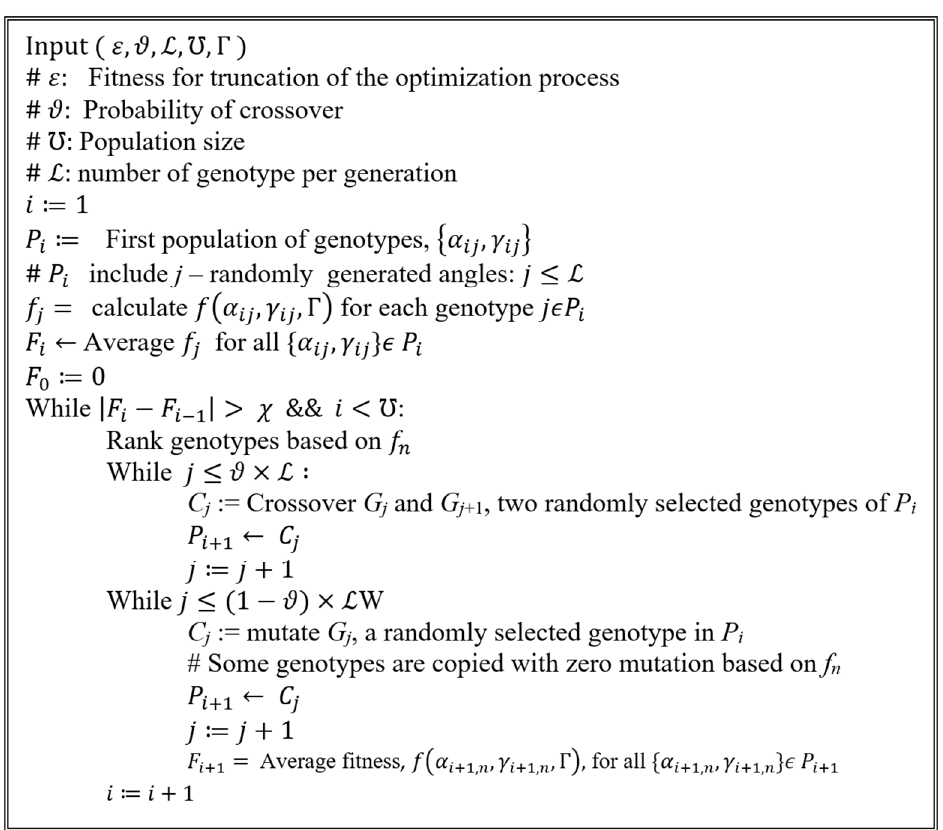
Figure 3. Shows a pseudo code for the GA implemented in the CDDOP. The code’s input consists of four parameters that define the GA behavior, and a vector of Γ that contains the coordinate of the location and the basic climatic data. The code returns the optimum tilt angle, α , and azimuth angle, γ , that corresponds to the maximum power generated by the PV panel.